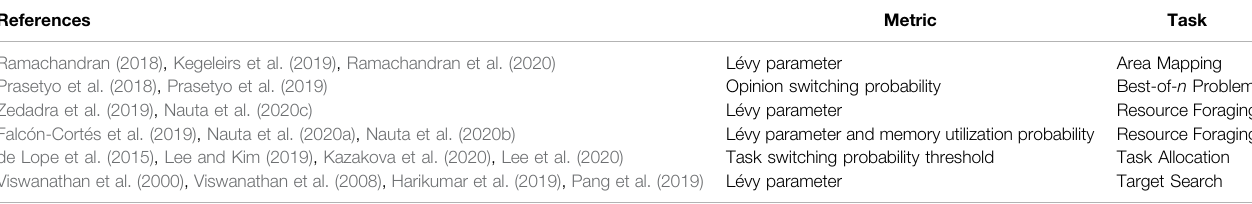
TABLE 2 | List of works using probability based metrics to quantify MAS exploration exploitation dynamics.